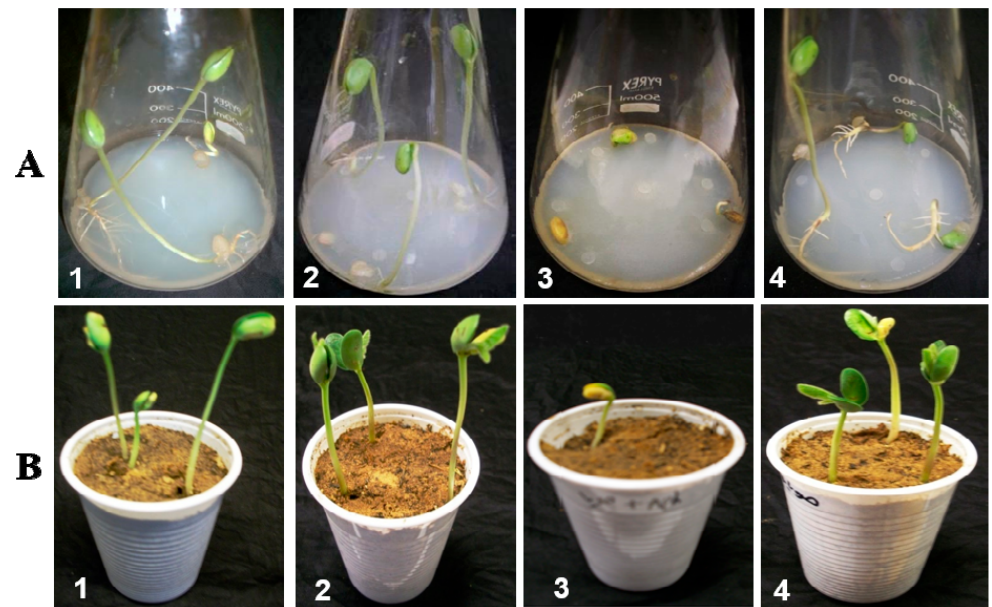
Figure 4. Bioactivity of P. oligandrum (MS 15 ) on P. aphanidermatum through the cultivation of G. max seeds on 2% water agar medium ( A ) and soil pots ( B ): 1, seeds cultivated alone as a control; 2, seeds cultivated with P. oligandrum alone; 3, seeds cultivated with P. aphanidermatum alone; 4, seeds cultivated with both of P. oligandrum and P. aphanidermatum. Table 5. Effects of G. max seed treatment with three isolates of bioagent P. oligandrum on the growth seed parameters.